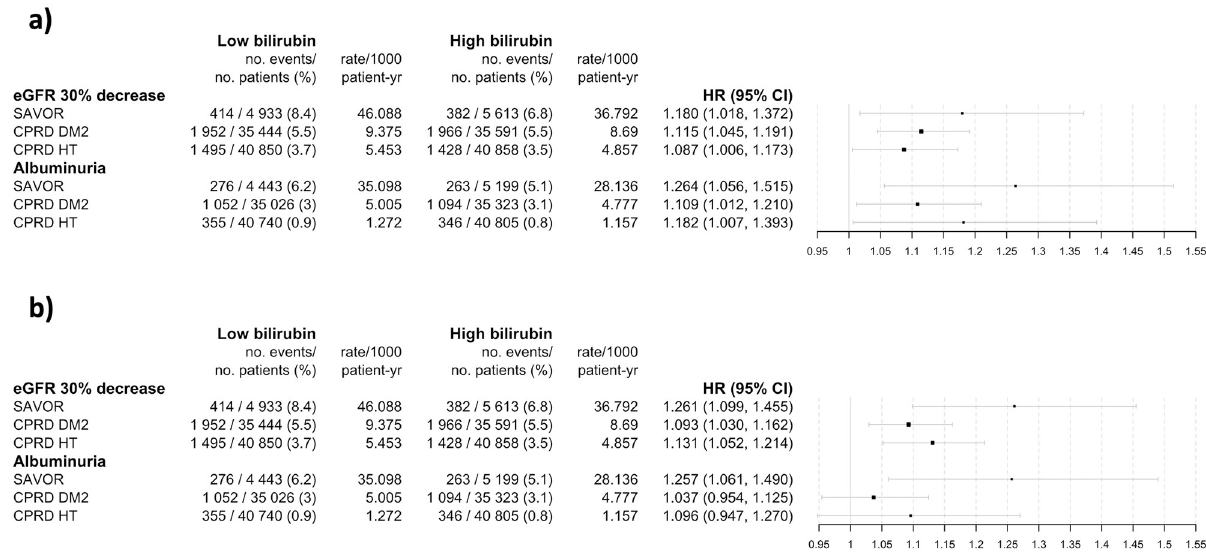
Fig 5. Primary and secondary endpoints, according to study cohorts. Hazard Ratio calculated with confounder adjustment and inverse probability weighting (panel a). Hazard Ratio calculated without any adjustment nor weighting (panel b). Shown is the primary endpoint of the study -estimated glomerular filtration rate (estimated by the CKD EPI formula) of more than 30% from the baseline- and the secondary endpoint of the study -first observation of the albuminuria (defined by the urine albumin creatinine ratio greater or equal to 30mg/mmol)- according to the study cohorts. High bilirubin denotes the patient subpopulation that has above or equal cohort median of the baseline serum bilirubin concentration (9 μ mol/L for SAVOR, 10 μ nil/L for CPRD-DM2 and HT), Low bilirubin denotes the patient subpopulation that has below cohort median of the baseline serum bilirubin concentration, HR hazard ratios in panel a, inverse probability weighted and adjusted for confounding covariates (age, sex, race if available, baseline body mass index, baseline hemoglobin, baseline alanine transaminase, baseline aspartate transaminase, smoking), HR hazard ratios in panel b, no inverse probability weighted and no adjustment, CI confidence interval calculated by fitting a normal distribution to the 1000 bootstrap sample of the